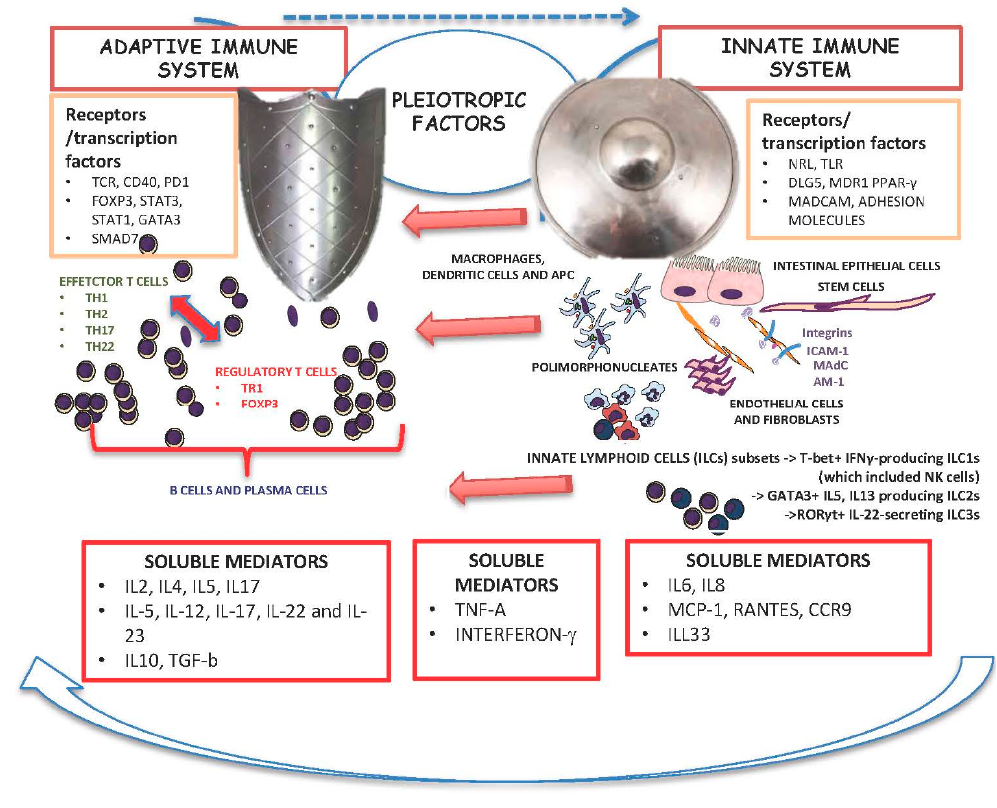
Figure 1. Innate and adaptive immune system.